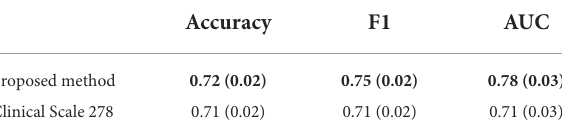
TABLE 2 Results of the proposed method and other indicators used in the previous